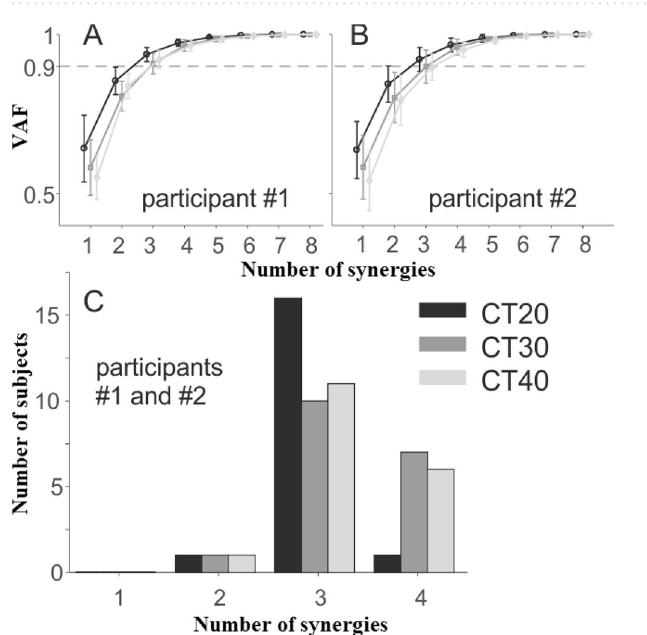
Figure 5. Cumulative variance and number of individual synergies in each experimental condition. Mean (± SD) of the Variance Accounted For (VAF) as a function of the number of synergies extracted for participant #1 ( A ), who holds the load with the right hand, and for participant #2 ( B ), who holds the load with the left hand. Frequency histogram corresponds to the number of synergies in each condition, as determined by the criterion “VAF > 90%” ( C ). Three synergies were selected for all participants in further